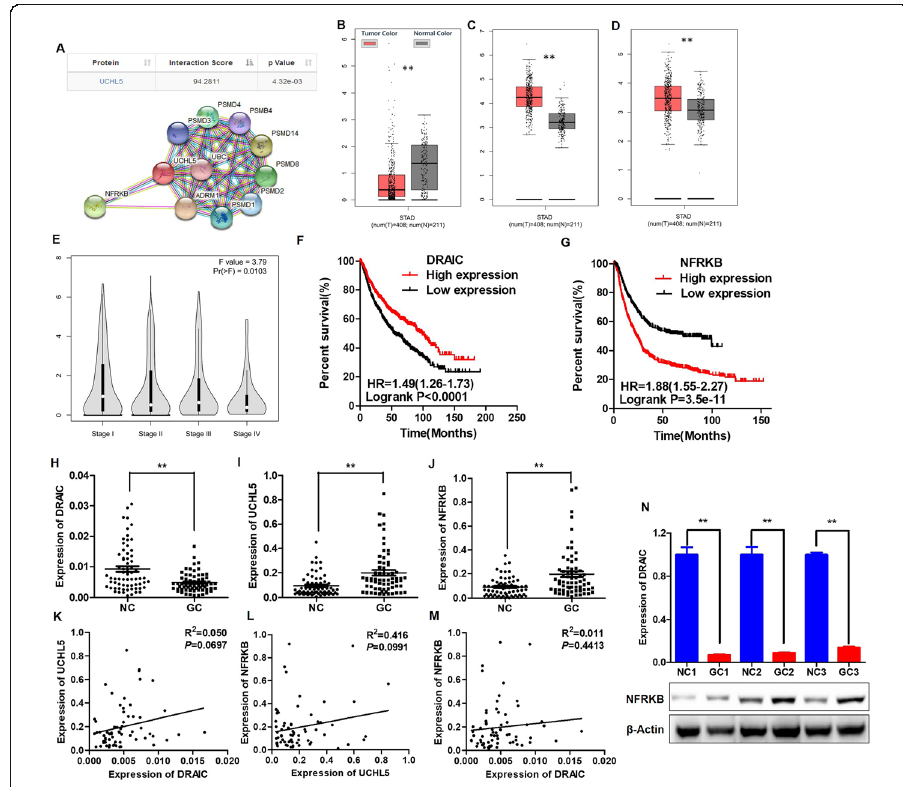
Fig. 1 Expression and correlations of DRAIC, UCHL5 and NFRKB in GC tissues. a. Bioinformatics analysis of interaction molecules of DRAIC. b. DRAIC expression in 408 cases of GC tissues and 211 cases of NC tissues from TCGA database. c. UCHL5 expression in 408 cases of GC tissues and 211 cases of NC tissues from TCGA database. d. NFRKB expression in 408 cases of GC tissues and 211 cases of NC tissues from TCGA database. e. DRAIC respective expression in GC patients with TNM stage I-IV. f. Kaplan-Meier curves for overall survival analysis as it correlates to DRAIC expression. g. Kaplan-Meier curves for overall survival analysis as it correlates to NFRKB expression. h. DRAIC expression in 67 paired GC tissues and NC tissues was determined by qPCR. i. UCHL5 expression in 67 paired tissues j. NFRKB expression in 67 paired tissues k. Analysis of the correlation of DRAIC and UCHL5 mRNA by Pearson correlation coefficient. l. Analysis of the correlation of UCHL5 mRNA and NFRKB mRNA by Pearson correlation coefficient. m. Analysis of the correlation of DRAIC and NFRKB mRNA by Pearson correlation coefficient. n. Analysis of the relationship between DRAIC and NFRKB protein. R 2 = coefficient of determination. Quantitative data are presented as means ± SD. ** P < 0.01 compared with the NC